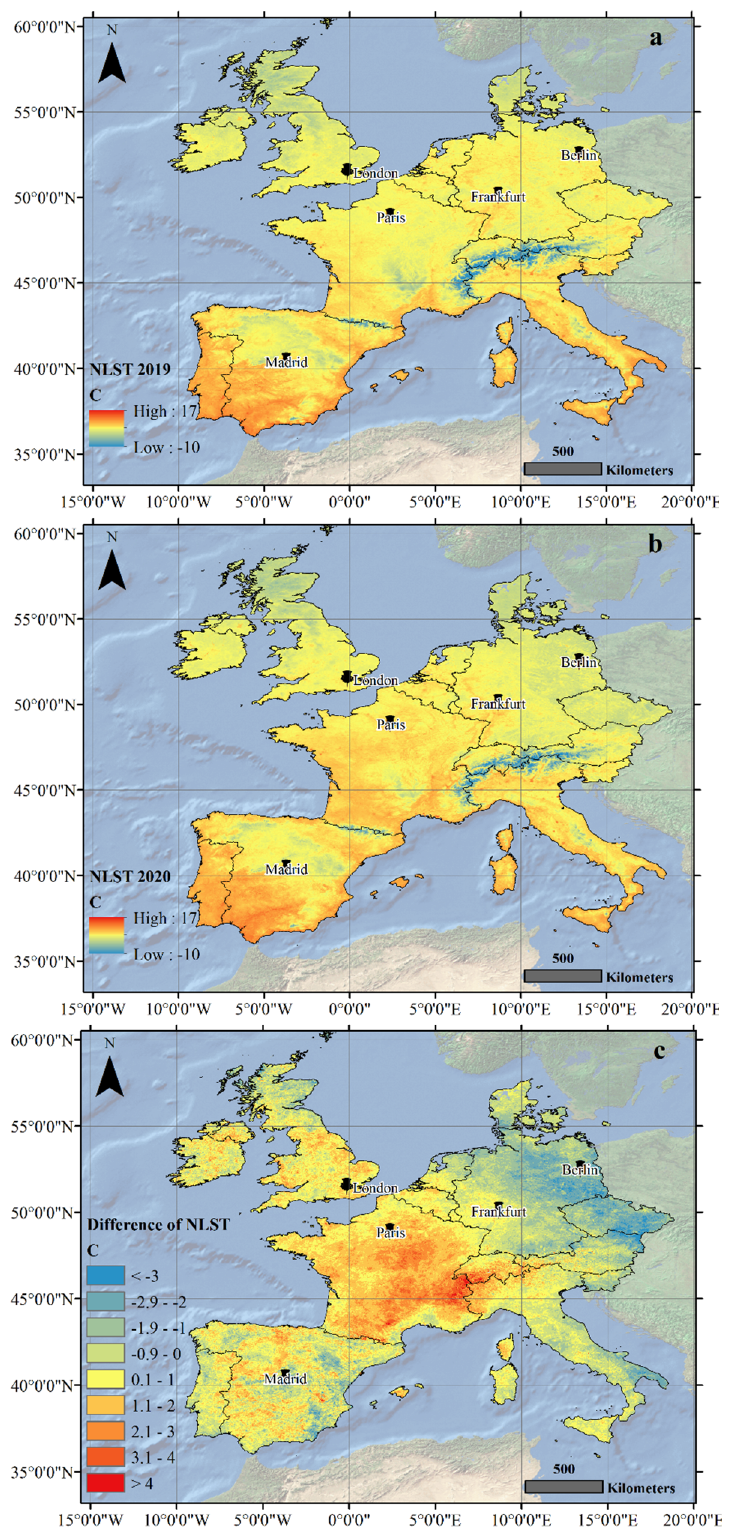
Figure 7. The average NLST of the study area from 23 March to 20 April in ( a ) 2019 and ( b ) 2020 and ( c ) the difference between the two years investigated, obtained from MOD11A1 images in centigrade degrees.